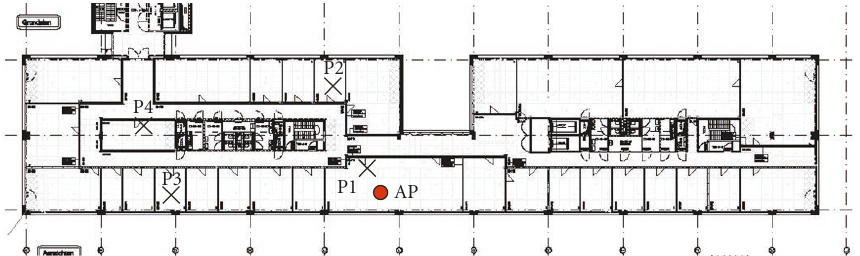
Figure 2: Floor plan of the test environment.